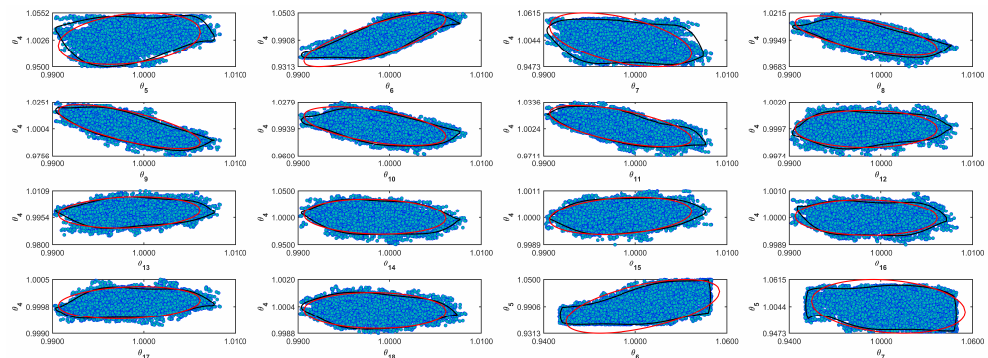
Figure A4. Coverage regions of parameters 04: (—) Gaussian region; (—) Possolo [33] region.